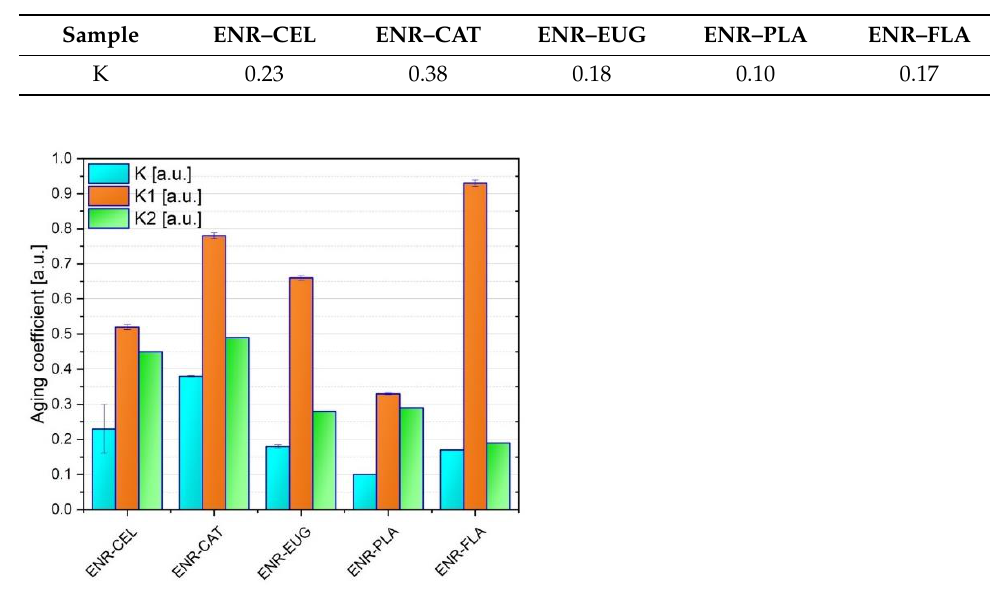
Figure 3. Tensile strength results (TS) ( A ), elongation at break (Eb) ( B ) of ENR-based mixtures with additional content. Table 1. Aging coefficients (K) of studied ENR-based compositions.